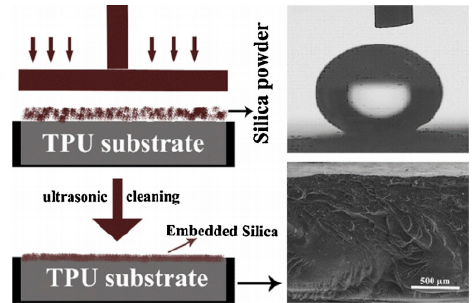
Figure 2. Schematic representation of the pressing method for fabrication of thermoplastic polyurethane/silica (TPU/silica) coatings ( left ) and cross-sectional morphology along with the water drop profile for the superhydrophobic sample ( right ) [18].